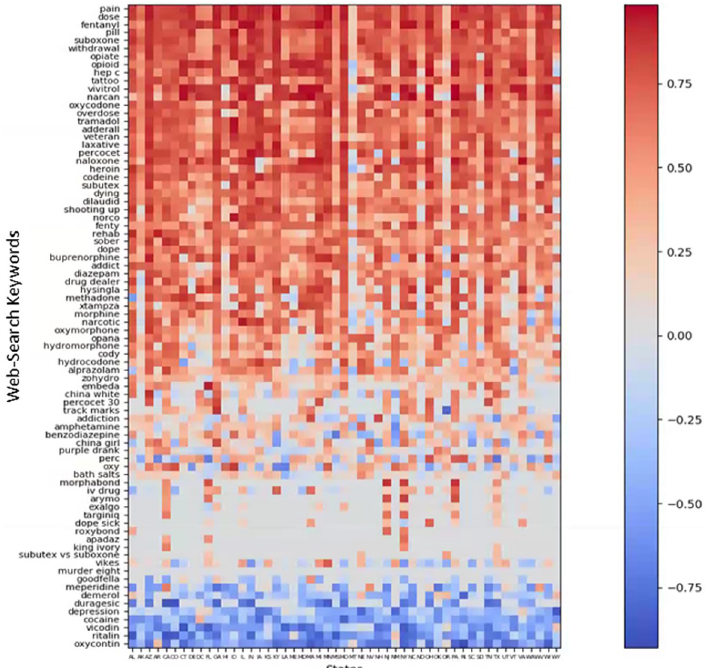
Fig 3. Correlation between web-search volumes by using individual keywords and yearly observed overdose death rates by states during 2004–2017.